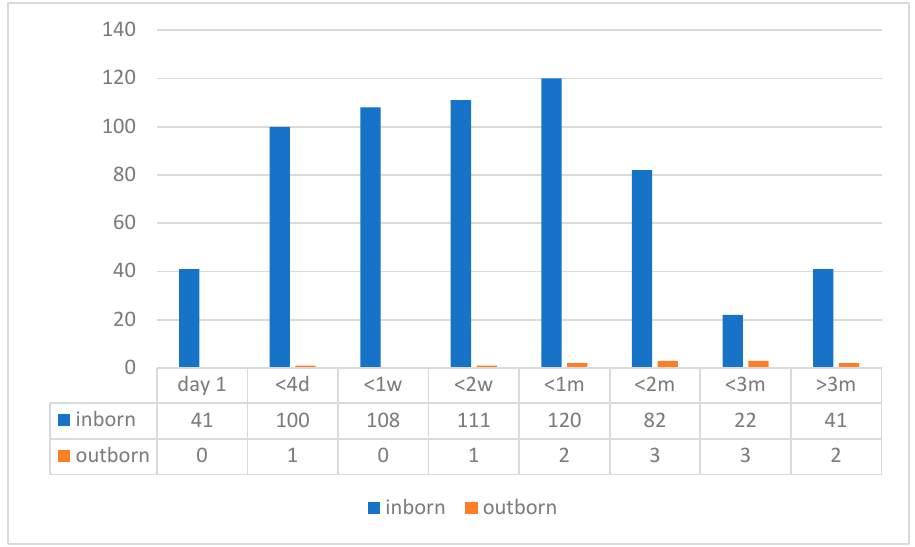
Figure A1. The time of death of infants who died during the study period. More than half of inborn infants died within 2 weeks after birth.